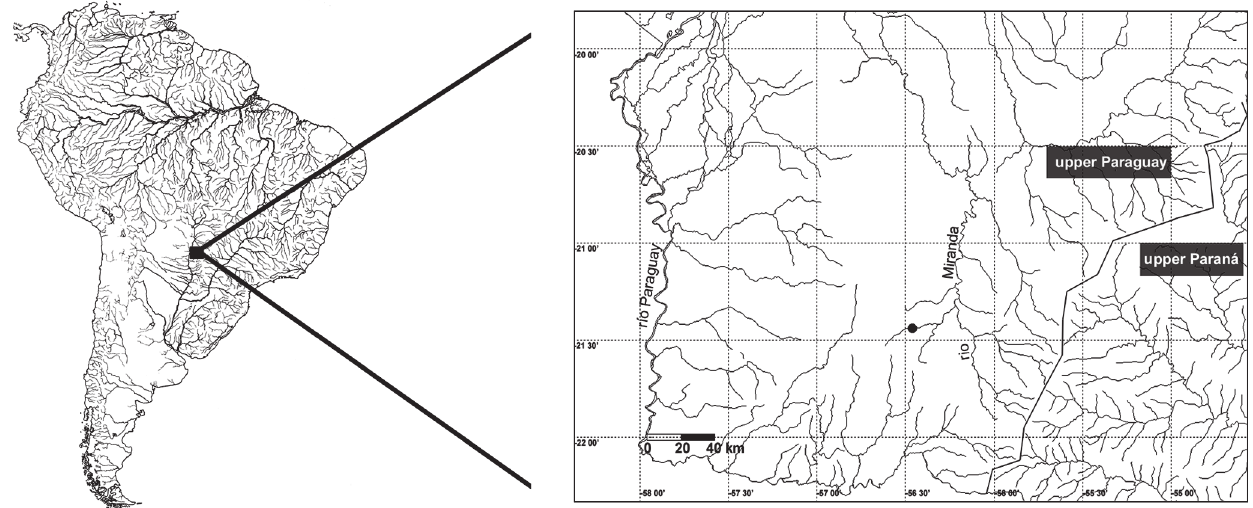
Fig. 1. Location of the study area, indicating the córrego Olho d’Água in South America (black